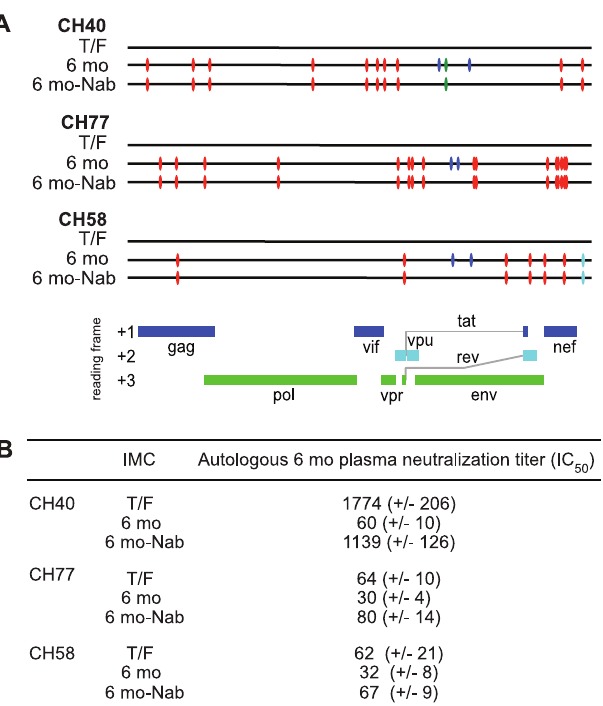
Figure 1. Sequences and autologous neutralization sensitivities of consensus infectious molecular clones. A. 6 mo and 6 mo-Nab IMC sequences are aligned to the T/F sequence with red and blue tics indicating non-synonymous changes implicated in CTL and Nab escape, respectively. Green tics denote synonymous changes and aqua tics changes in non-coding regions. B. Neutralization of IMCs by autologous 6 month plasma is reported as mean ( + / 2 SD) reciprocal plasma dilutions (IC 50 ). Experiments were conducted in triplicate and repeated three